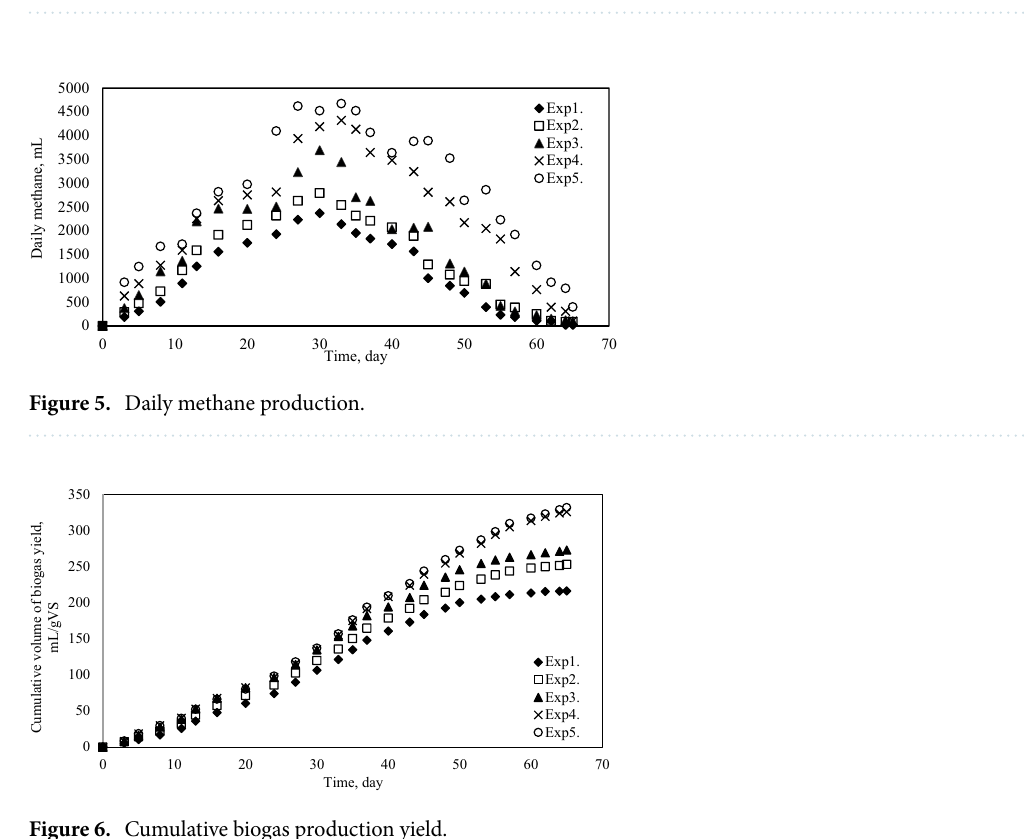
Figure 4. Methane percentages.